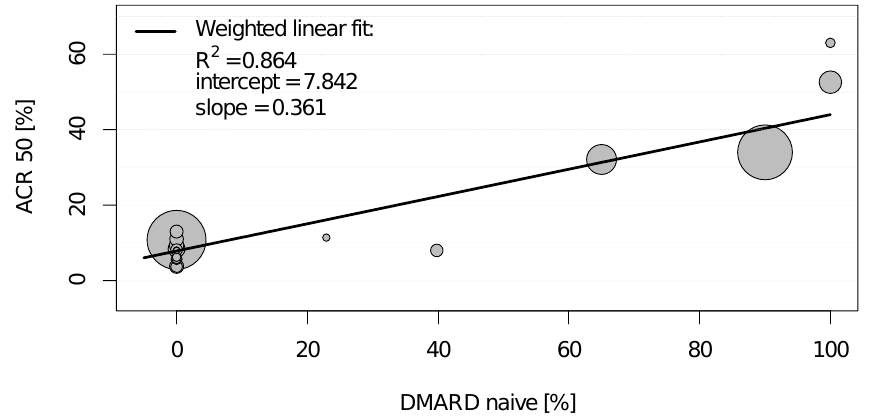
Figure 1. Scatter plot showing the positive weighted Pearson correlation between proportions of patients with rheumatoid arthritis achieving American College of Rheumatology score 50 (ACR50) and proportions of disease-modifying anti-rheumatic drug (DMARD)-naïve patients in the placebo groups. Each circle represents the study size for an individual placebo group.